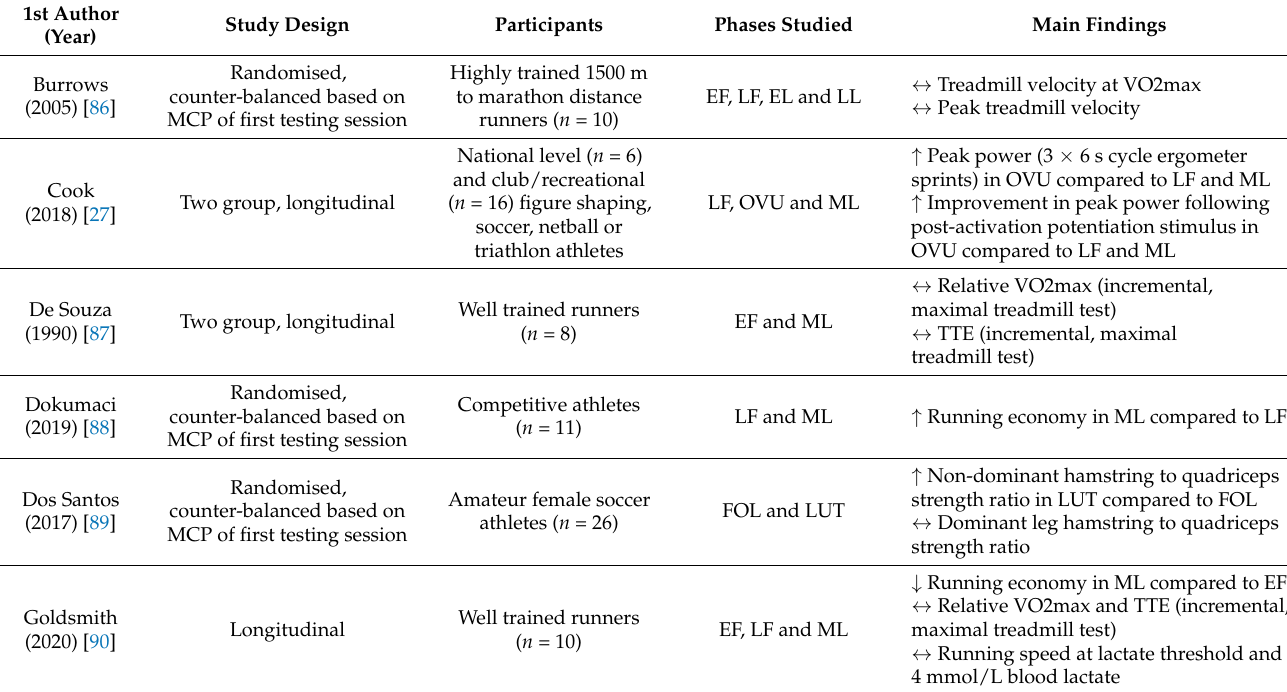
Table 2. Details and findings of studies on the effect of the menstrual cycle on objectively measured performance in athletes. 1st Author